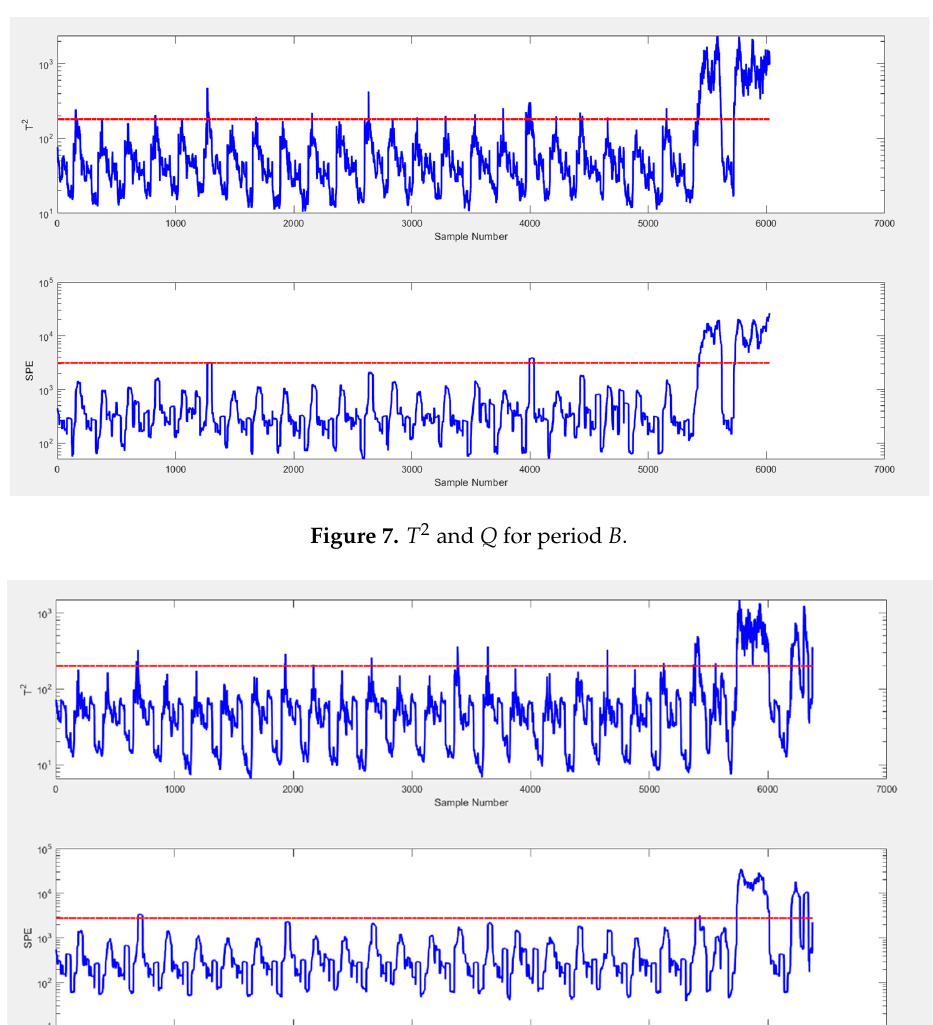
Figure 9. (cid:1846) 2 and Q for period D . Figure 10. (cid:1846) 2 and Q for period E .